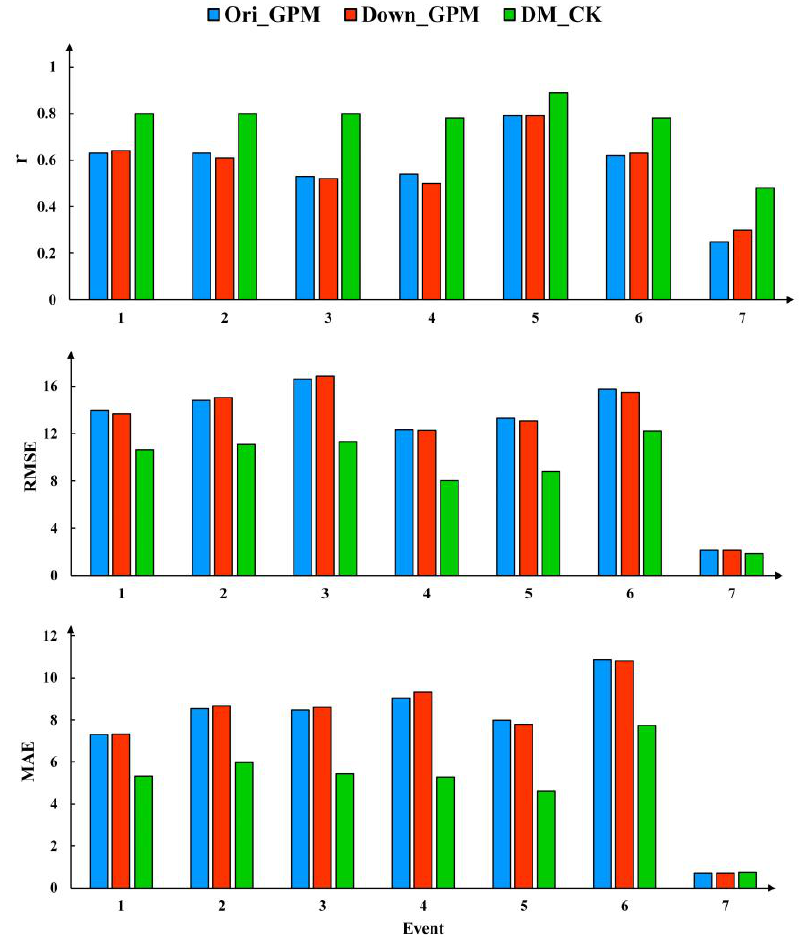
Figure 6. Evaluation for quantitative indices for the Ori_GPM; Down_GPM and DM_CK at the